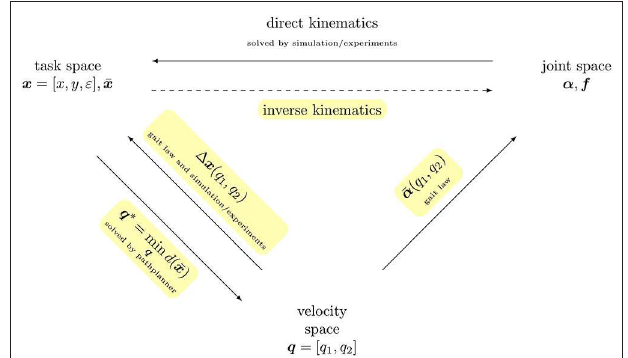
FIGURE 1 | Overview of spaces: in order to approximate the inverse kinematics, the joint space of the robot is reduced by formulating constraints referred to as gait law ¯ α . The remaining two generalized coordinates q define the so-called velocity space. The direct kinematics of the entire velocity space (mapping in Cartesian task space) is approximated by a bivariate polynomial 1 x . By formulating an optimization problem min d ( ¯ x ) that recursively generates the reference minimizing the distance to a given target position ¯ x , the robot can be operated in task